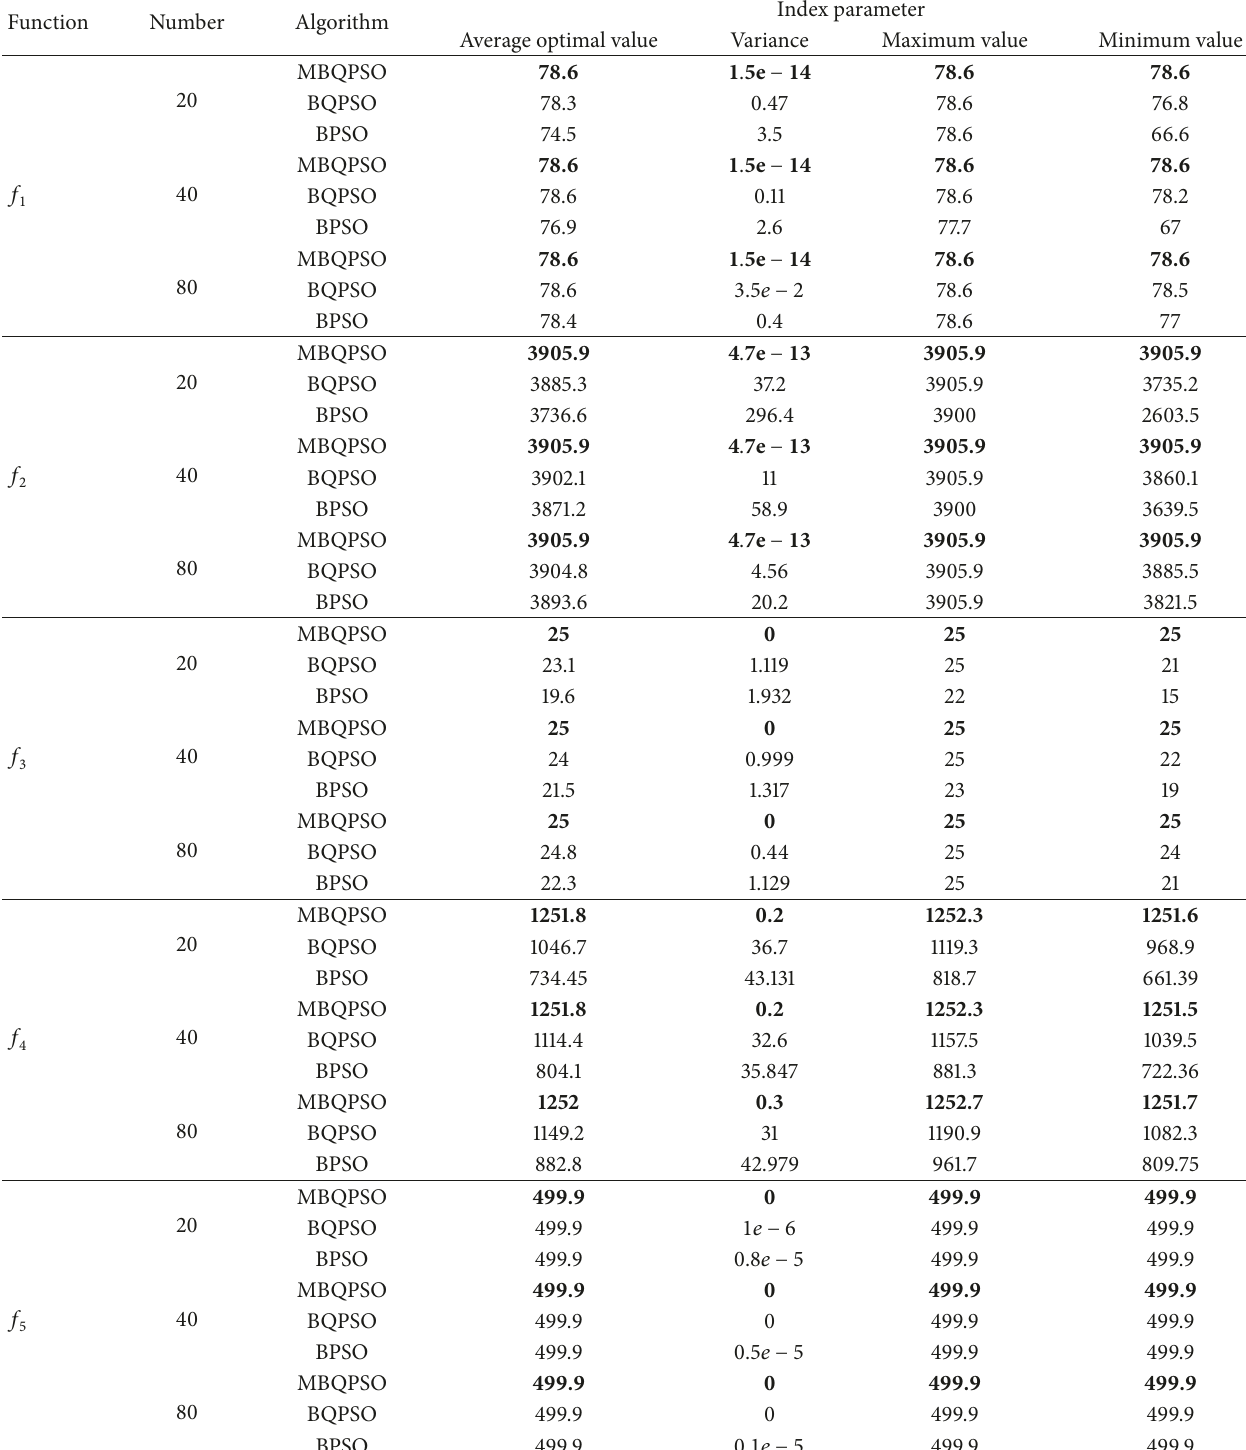
Table 2: BPSO, BQPSO, and MBQPSO algorithm simulation results with five test functions.